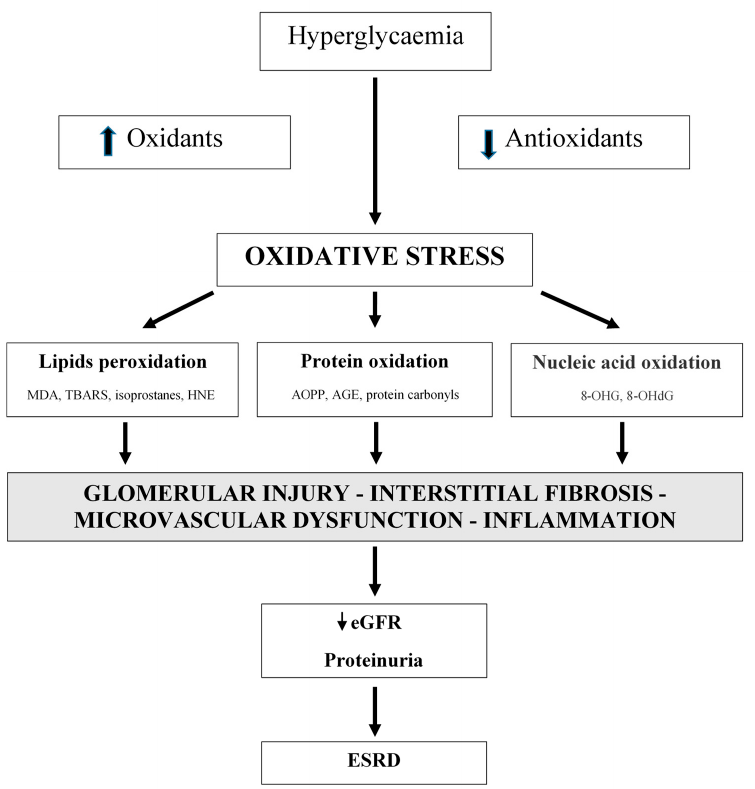
Figure 1. Oxidative stress is a significant factor in the development of diabetic nephropathy. Oxidative stress is associated with metabolic changes and alterations in renal